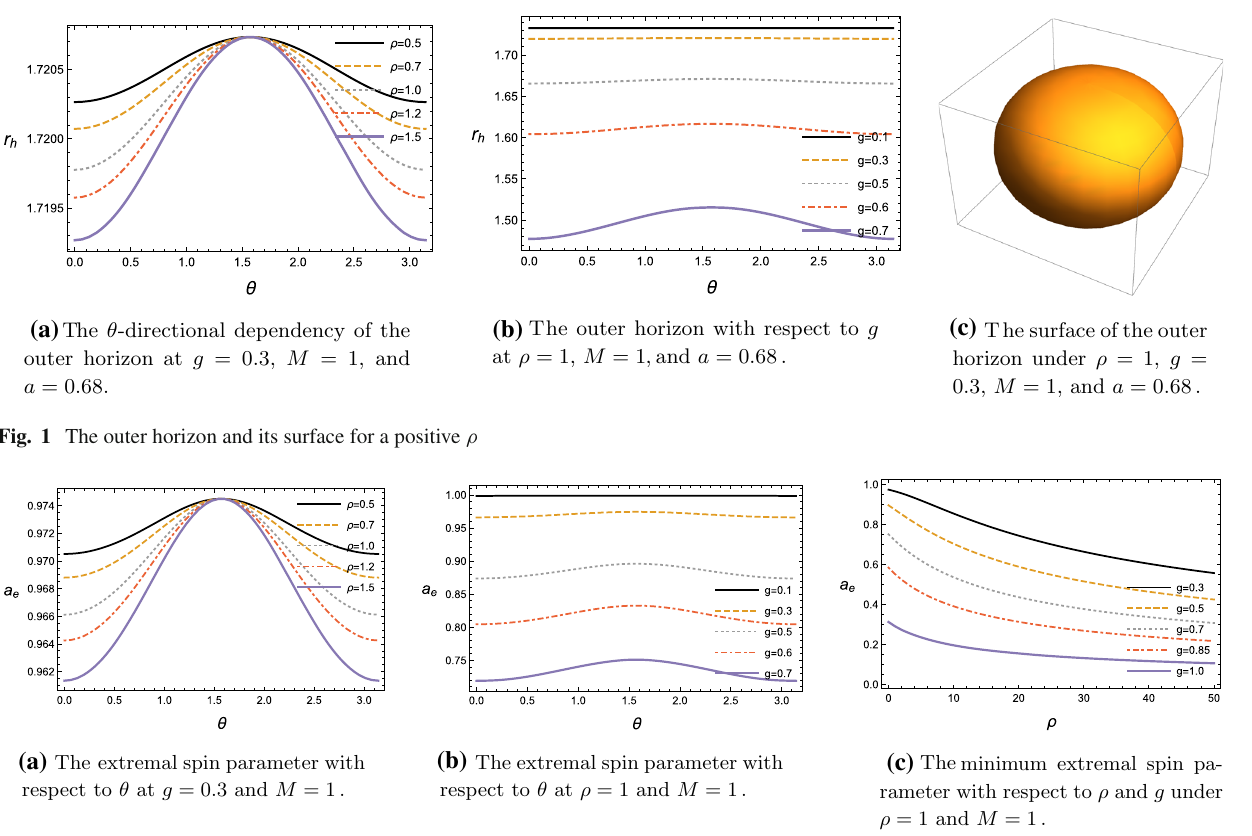
Fig. 4. At the north and south poles of the black hole, the extremal spin parameters are the maximum, and at the equa- tor, the extremal spin parameter is the minimum, as shown in Fig. 4a. For the change of the parameter g , the extremal